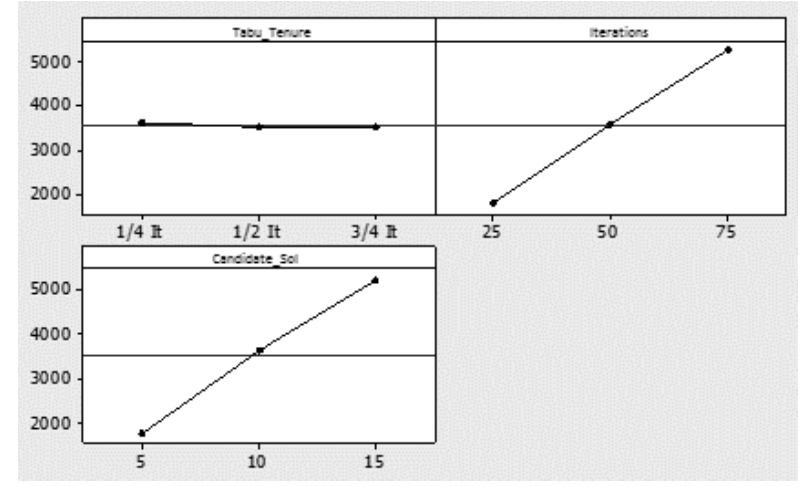
Figure 4. Main effects plot for total computational time in large instances. Source: Minitab R (cid:13)